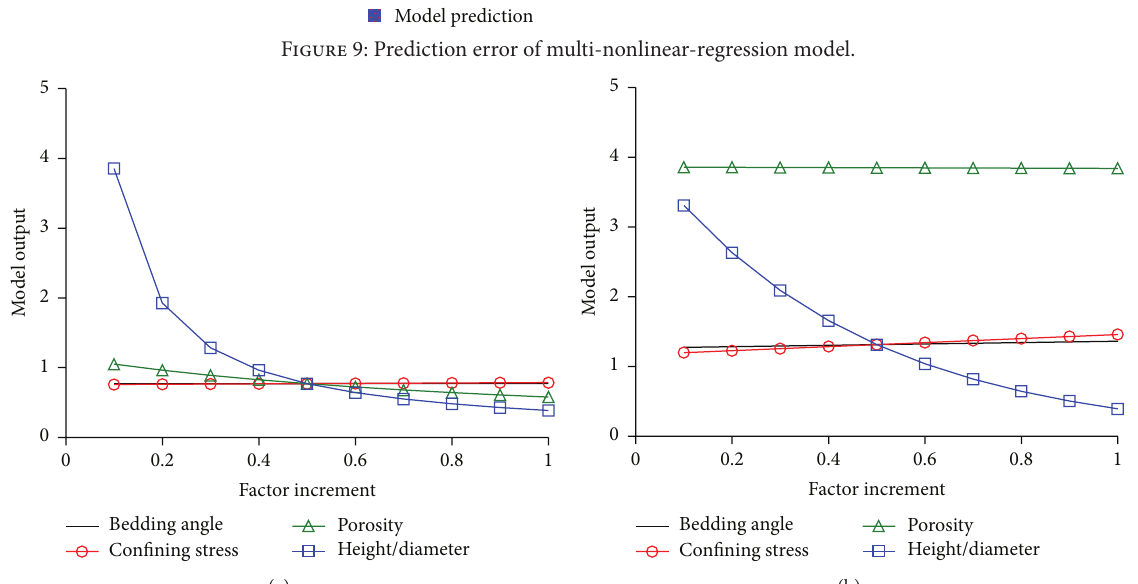
Figure 10: Sensitivity analysis of both models: (a) dimension analysis-based model; (b) multi-nonlinear-regression